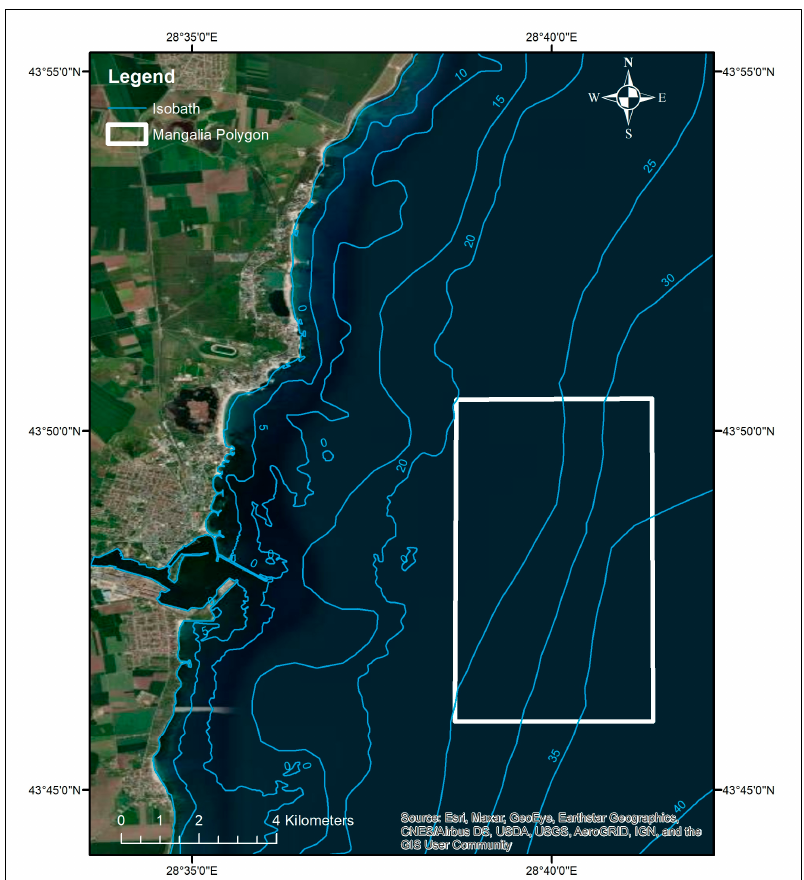
Figure 3. Bathymetric map of the Mangalia area, Romania .